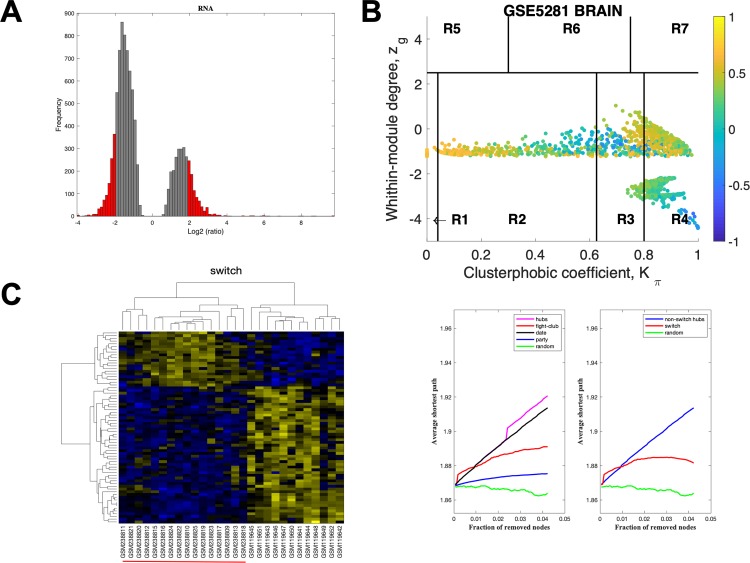
SWIM analysis of the mid temporal gyrus.A. Distribution of the fold-change values for GSE5281 brain microarray gene expression data from the MTG. The x-axis represents the fold-change value (log2 of the fold-change) that is the ratio of the average expression data in AD patients compared to the average expression data in normal controls computed for protein-coding and non-coding RNAs. The y-axis represents the frequency of the obtained fold-change values. The grey bars represent the fold-change values associated with protein-coding and non-coding RNAs that will be discarded according to the selected threshold. The red bars represent the fold-change values associated with protein-coding and non-coding RNAs that were retained for further analysis. B. Heat cartography map for GSE5281 brain data from the MTG. correlation network. The plane is identified by two parameters: Zg (within-module degree) and Kπ (clusterphobic coefficient) and it is divided into seven regions each defining a specific node role (R1-R7). High Zg values correspond to nodes that are hubs within their module (local hubs), whereas low Zg values correspond to nodes with few connections within their module (non-hubs within their communities, but they could be hubs in the network). Each node is colored according to its average Pearson Correlation coefficient (APCC) value. Yellow nodes are party and date hubs, which are positively correlated in expression with their interaction partners. Blue nodes are the fight-club hubs, which have an average negative correlation in expression with their interaction partners. Blue nodes falling in the region R4 are the switch genes, which are characterized by low Zg and by high Kπ values and are connected mainly outside their module. C. Dendrogram and heat map for switch genes in GSE5281 brain microarray gene expression data from the MTG. The expression profiles of switch genes (including protein-coding and non-coding RNAs) are clustered according to rows (switch genes) and columns (samples) of the switch genes expression data (biclustering). The colors represent different expression levels that increase from blue to yellow. The red line under the x axis labels denotes AD samples. D. Robustness for the GSE5281 brain correlation network from the MTG. The x-axis represents the cumulative fraction of removed nodes, while the y-axis represents the average shortest path. The shortest path between two nodes is the minimum number of consecutive edges connecting them. Each curve corresponds to the variation of the average shortest path of the correlation network as function of the removal of nodes specified by the colors of each curve.